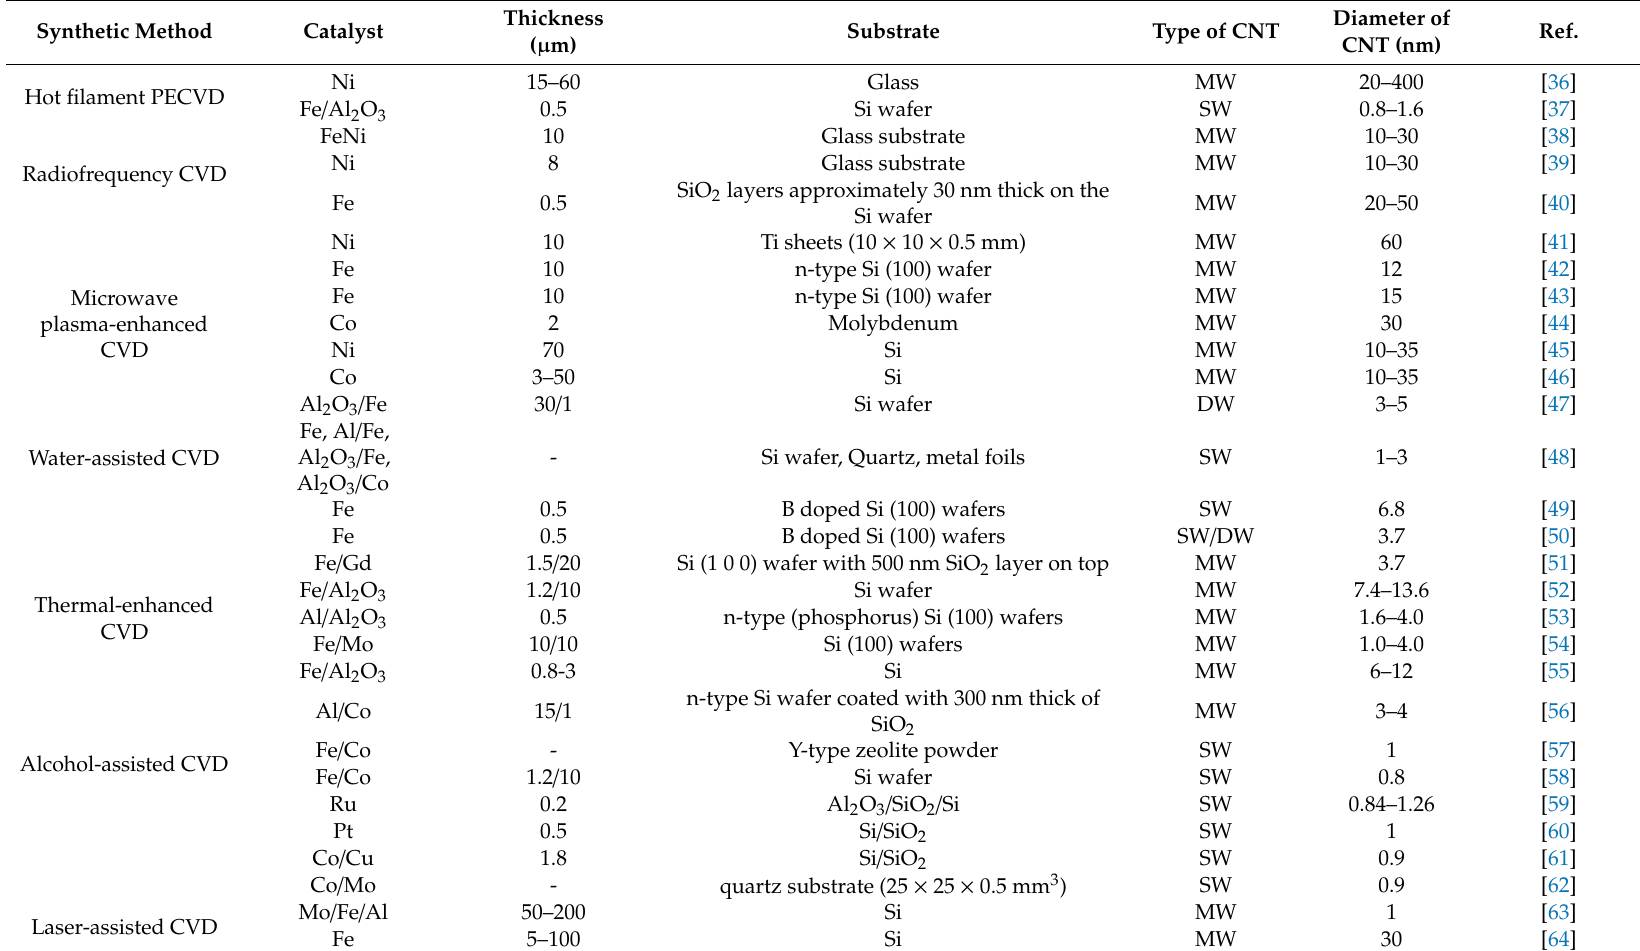
Table 2. Comparison of synthetic methods and characteristics of di ff erent vertically aligned carbon nanotubes